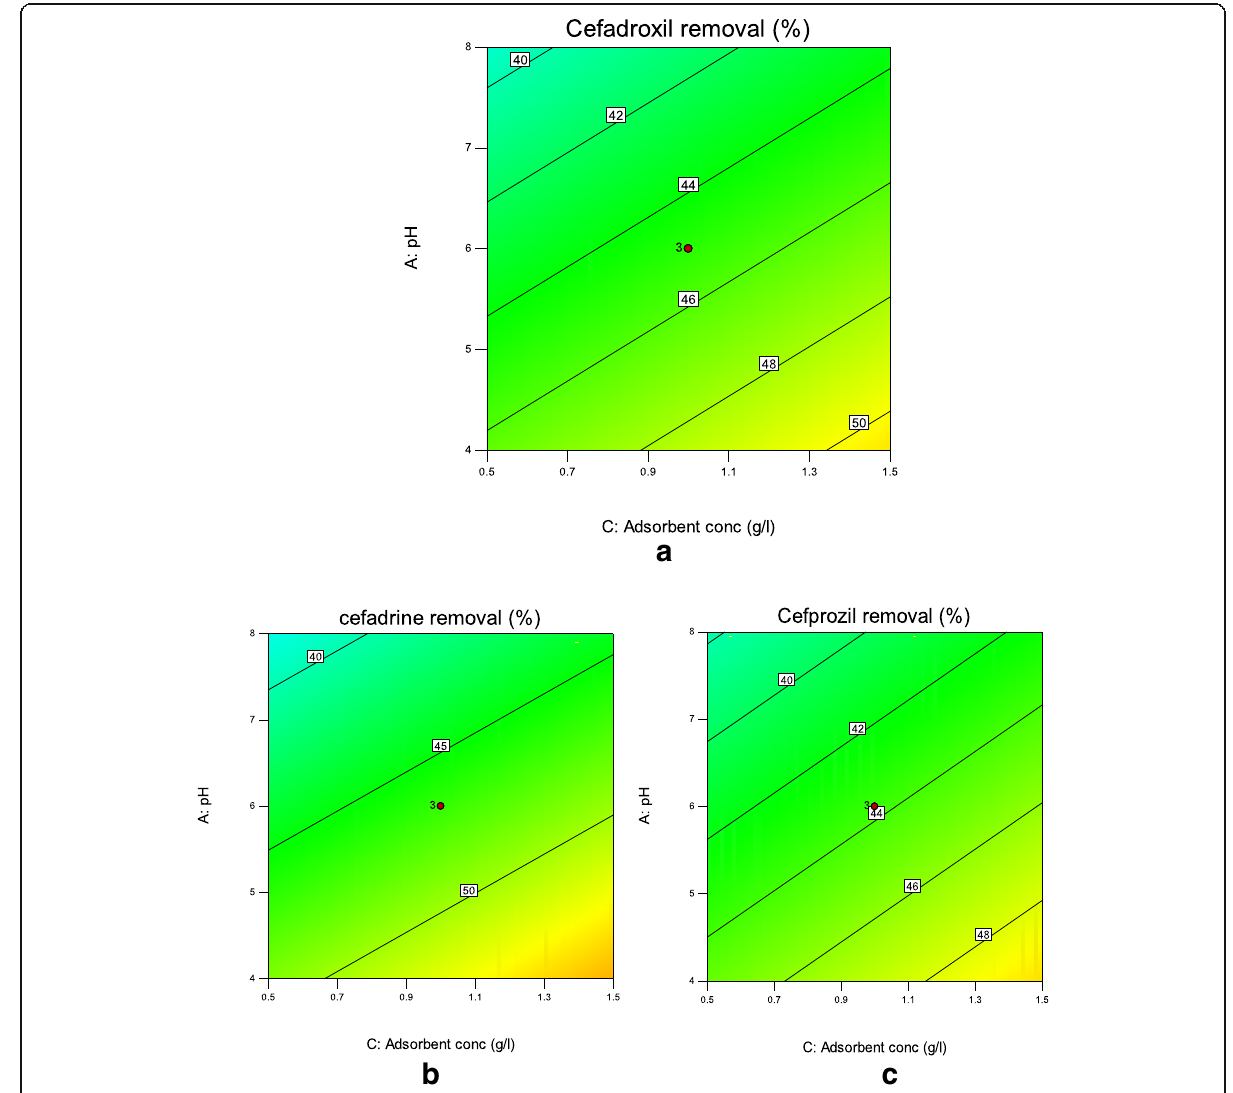
Fig. 4 Interaction of pH with MSN loading dose at constant initial concentration of 0.12 g/L for a cefadroxil, b cefprozil, and c